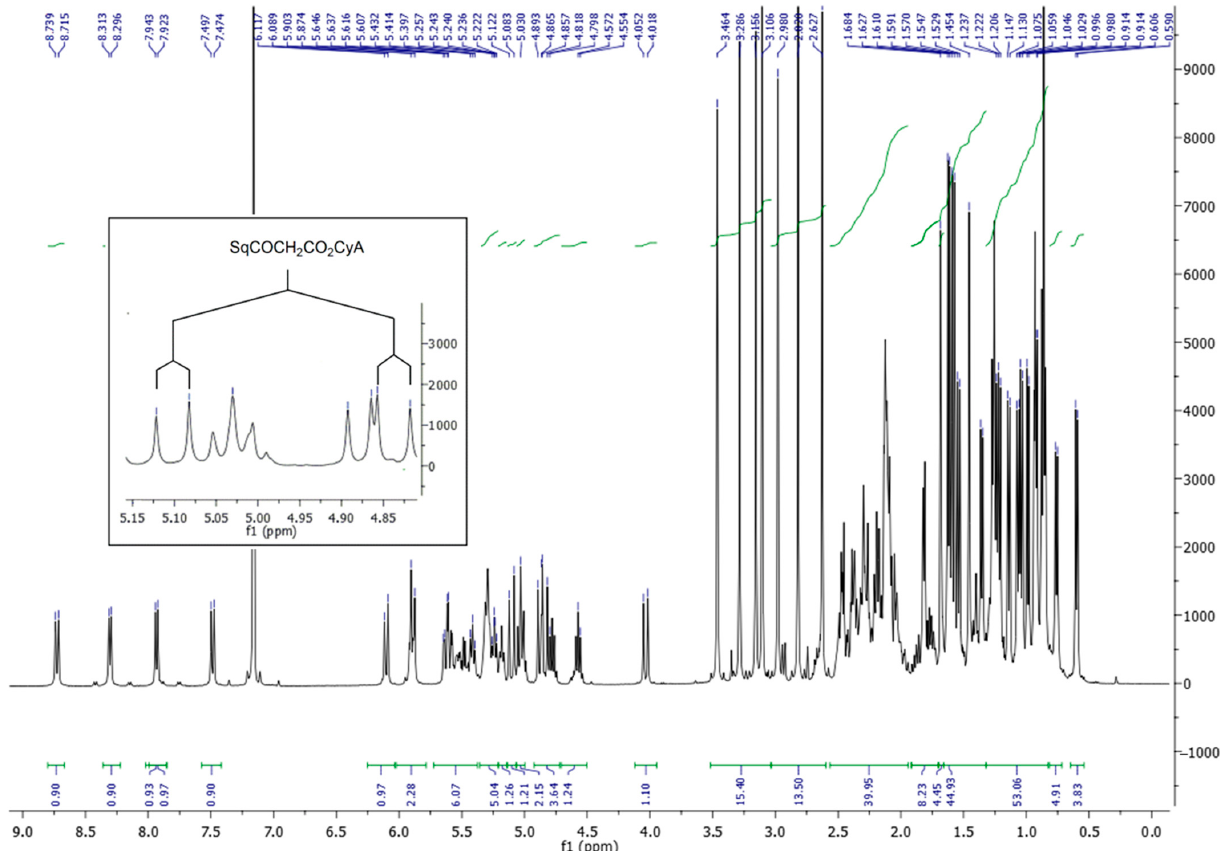
Figure 2. 1 H NMR of SqCsA (400 MHz, C 6 D 6 ). The AB system of the methylene system; the glycolate linker is enlarged.